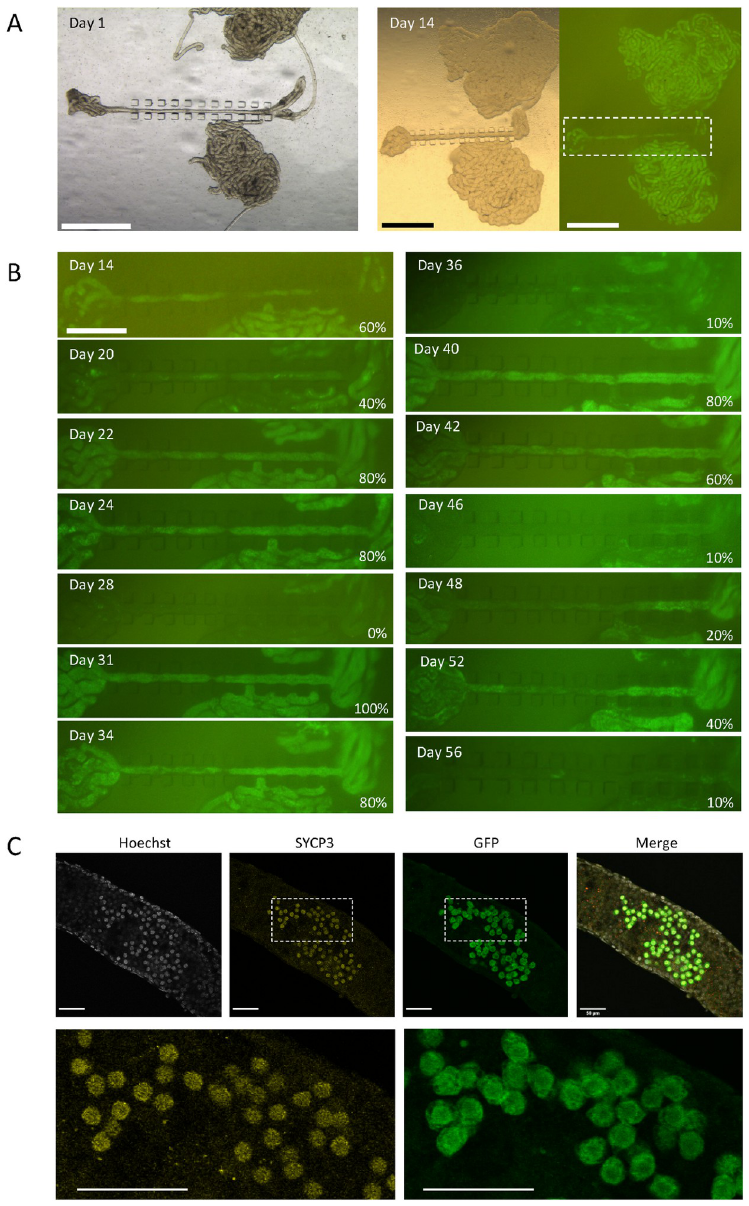
Fig 2. A long-term culturing of uncut-isolated STs using STPC chips. (A) A testis of an Acr -GFP mouse of 3 dpp were dissected and STs were set under STPC chips for culturing. On culture day 14, GFP expression was observed. The dashed rectangular region is enlarged in B. (B) Photographs taken sequentially on each culture day under excitation light for GFP recognition were aligned. GFP expression rates are noted in the lower right corner of each panel. (C) Confocal microscopic photos of whole-mount immunochemical staining of an uncut-isolated ST were taken on culture day 34, using a 5 dpp mouse testis. SYCP3- and GFP-positive cells represent meiotic spermatocytes. Scale bar: 1 mm (A), 0.5 mm (B), 50 μ m